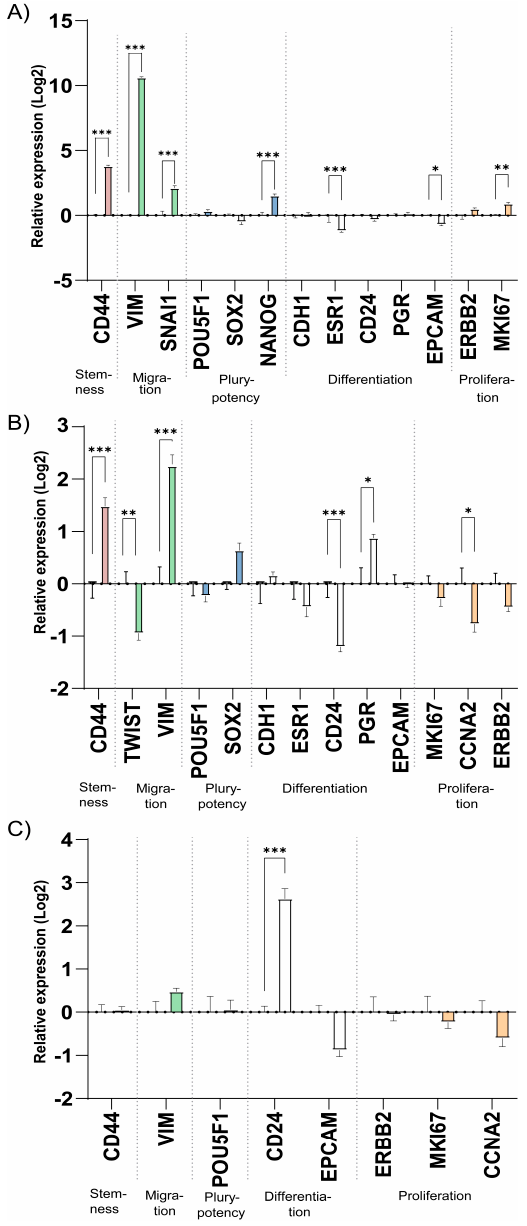
Figure 5. The microenvironment of 3D printed TEMPO-CNF scaffolds alters expression of stemness and migration gene markers. Gene expression levels analyzed by qPCR on cells cultured for 2 weeks in 3D scaffolds and 48 h in 2D for the cell lines ( A ) MCF7, ( B ) T47D and ( C ) MDA-MB-231. The data was normalized against the gene expression of the 2D control, set to zero for each gene. Average ± standard error of the mean ( n = 3). Two-way ANOVA; Sidak’s post hoc test for multiple comparison (2D). * p -value < 0.05, ** p -value < 0.01, *** p -value < 0.001. To test the stemness properties of the 3D TEMPO-CNF cultured MCF7 and MDA- MB-231 cells at cellular level we performed the holoclone formation assay. The 3D TEMPO-CNF environment significantly increased the ability to form holoclones for both MCF7, with 120%, and MDA-MB-231 cells, with 54%, compared with 2D cultured cells (Figure 6A).